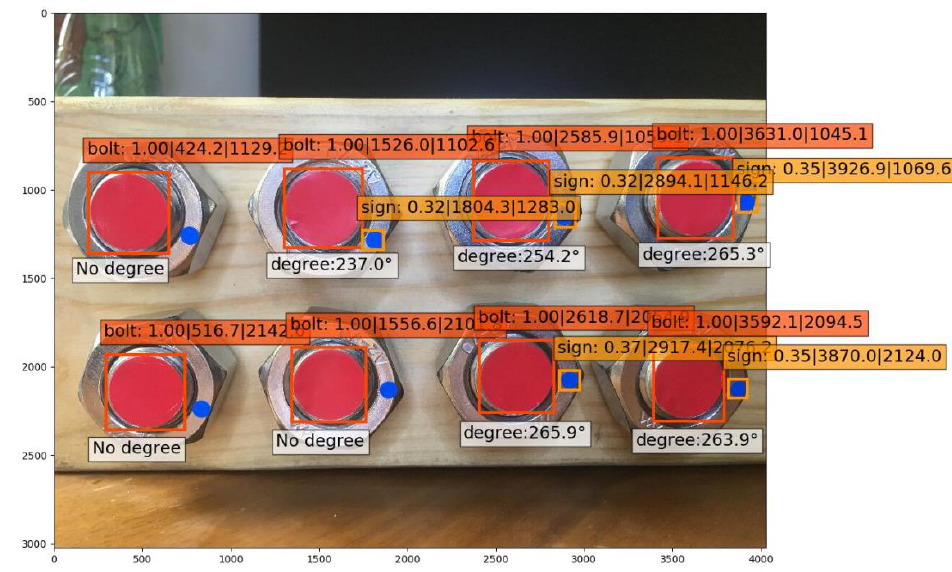
Figure 17. Identification results of an eight-bolted connection.